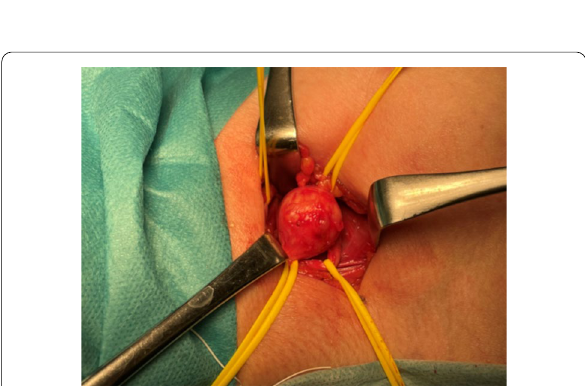
Fig. 3 A tumor arising from the medial cord of the brachial plexus was observed